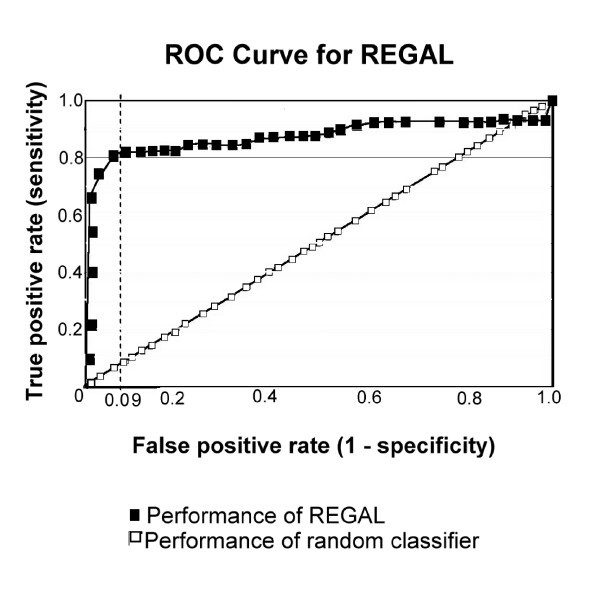
ROC curve for REGAL. ROC curves are used to evaluate the ability of a classifier to distinguish between true positives and false positives. With any classifier, increases in sensitivity will inevitably lead to more false positives. When a classifier behaves in an entirely random fashion, then each stepwise increase in sensitivity will lead to a stepwise increase in false positives. This is shown on the plot below as a 45° line. The better the classifier, the higher the curve rises along the left hand side of the plot, indicating stepwise increases in sensitivity with minimal increases in the false positive rate. This is the case for REGAL (line with black boxes). We note that the optimal point for sensitivity versus false positive rate is at a value of 0.82 for sensitivity and 0.09 for the false positive rate (indicated by the dashed line). In other words, the best performance by REGAL on the A. thaliana mitochondrial data set yields a sensitivity of 82% and a false positive rate of just 9%.